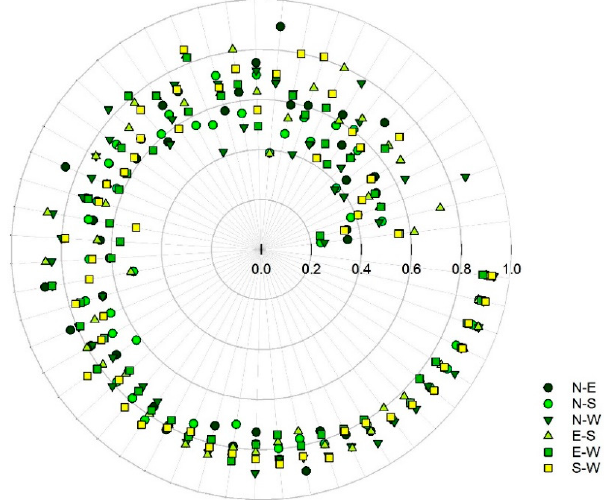
Figure 2. The results of correlation analysis among tree ring index in four directions of individuals. Different colors and shapes represent different pairs of directions.